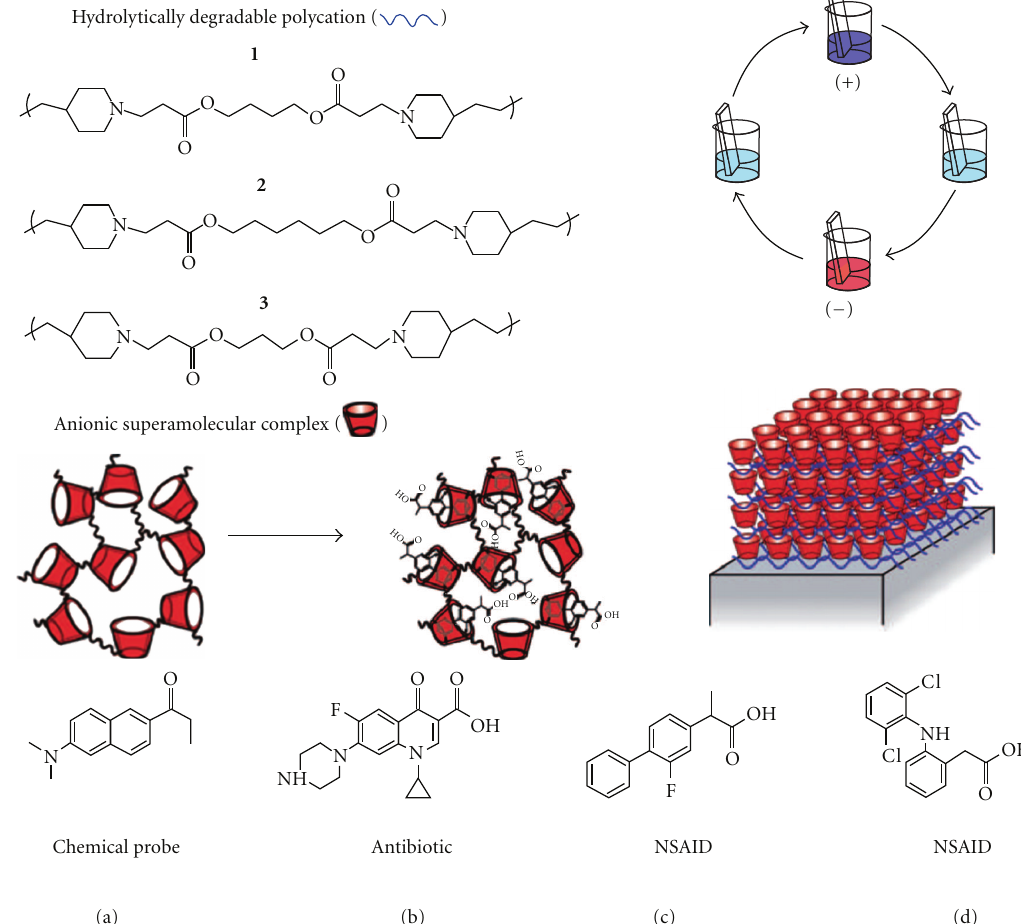
Figure 6: Methodology for LbL films. Left: film components. Three poly( β -amino esters) were investigated as degradable polycations. Poly(carboxymethyl- β -cyclodextrin) was used as the anionic supramolecular complex. Right: electrostatic assembly. Light blue: water. (+) indicates addition of polycation. ( − ) indicates addition of anionic supramolecular complex. Bottom shows molecules used in experimentation. NSAID: nonsteroidal anti-inflammatory drug